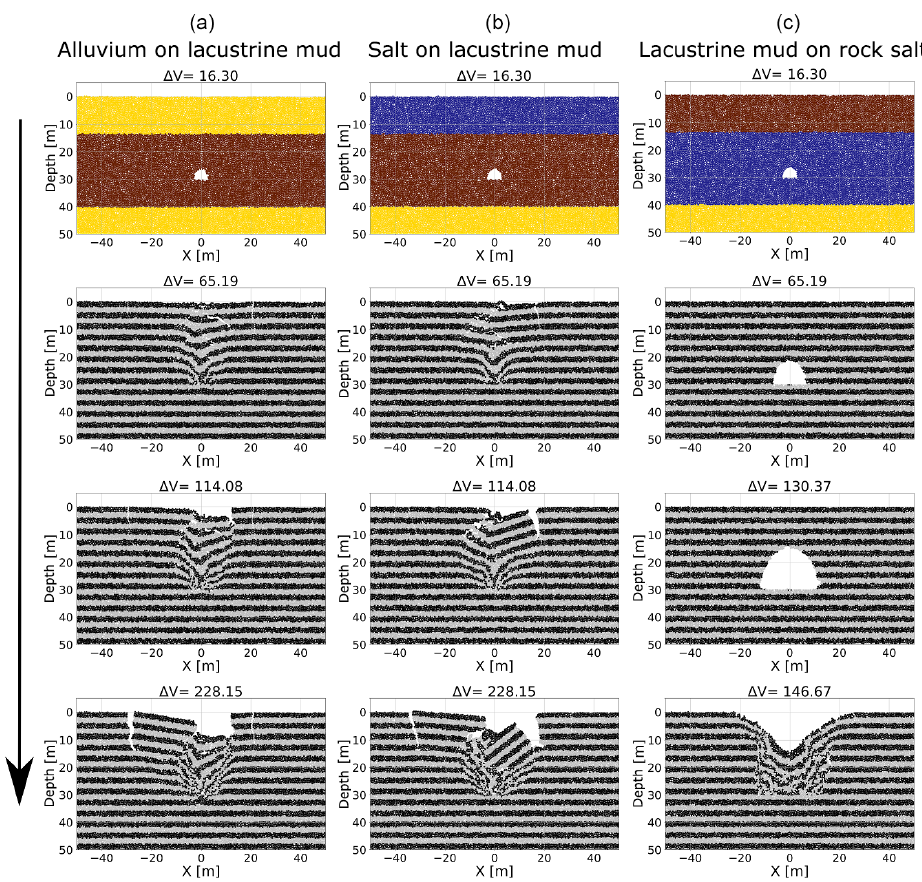
Figure 10. Evolution of DEM model cavity growth and sinkhole collapse in layered configurations of the end-member Dead Sea materials. Shown here are selected stages in the development of cavity/sinkhole in salty mud overlain by alluvium (a) , salty mud overlain by rock salt (b) and rock salt overlain by salty mud (c) . The top row shows the initial cavity growth stage for each material. Note that the initial cavity again closes rapidly in the mud, leading to a broader zone of subsurface